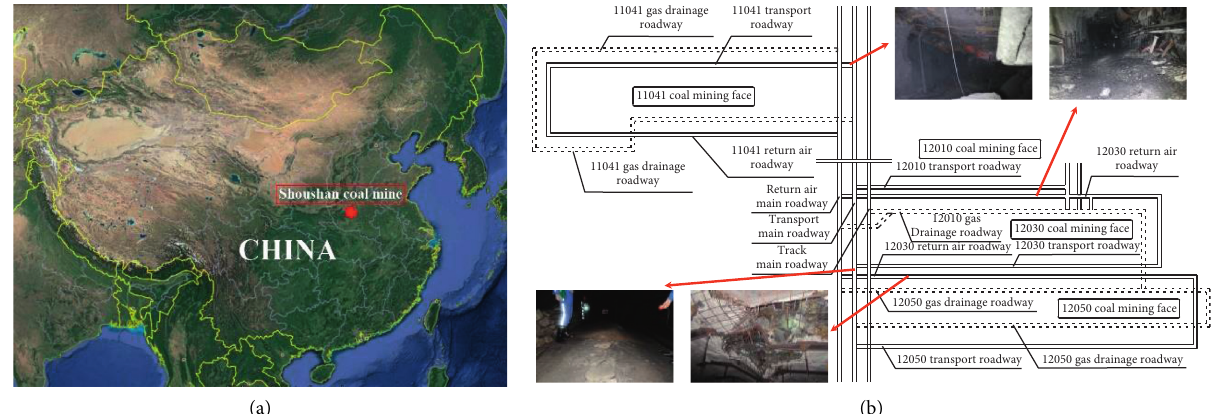
Figure 1: (a) Location of coal mine; (b) the deformation and fracture situation of the roadway.